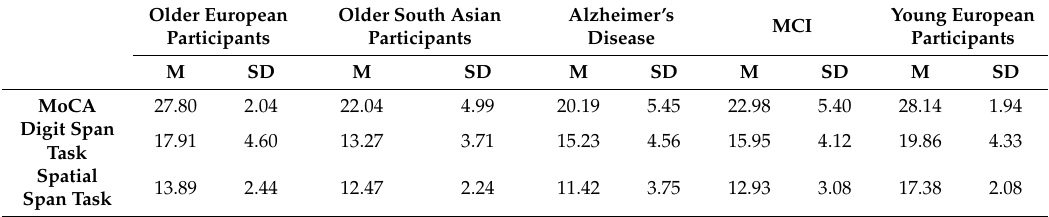
Table 1. Table displaying mean reaction times and standard deviations for the neurological assessments. MCI—mild cognitive impairment.